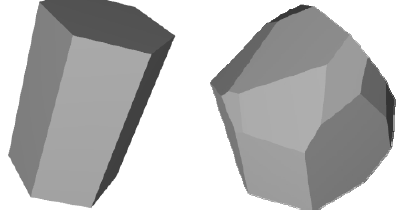
Figure 1 Particles for the calculation: the solid hexagonal column (left) and the arbitrary formed particle (right).